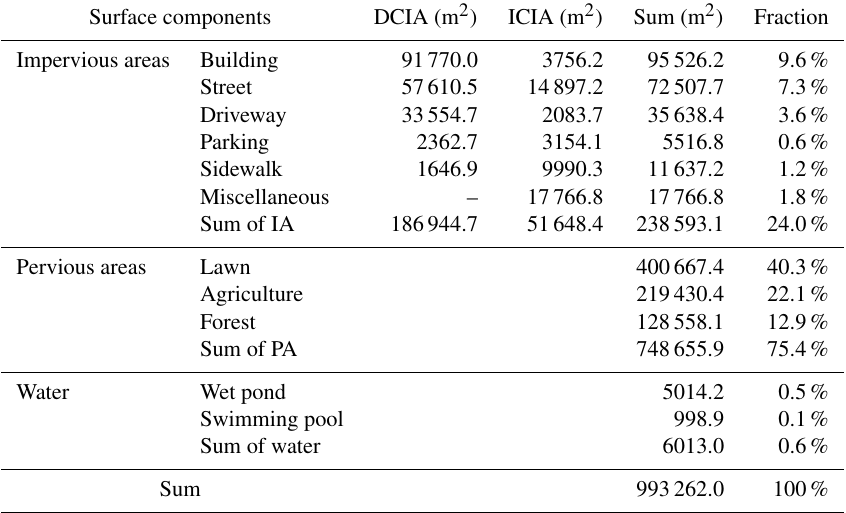
Table 3. Land cover status of Shayler Crossing